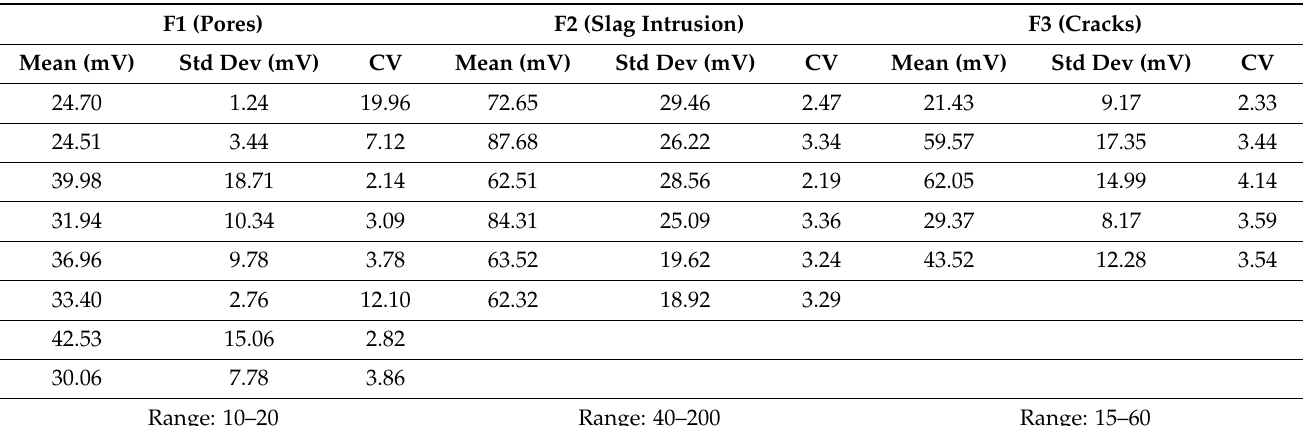
Table 6. Mean (mV), standard value (mV) and coefficient of variation for pores (F1), slag intrusion (F2) and cracks